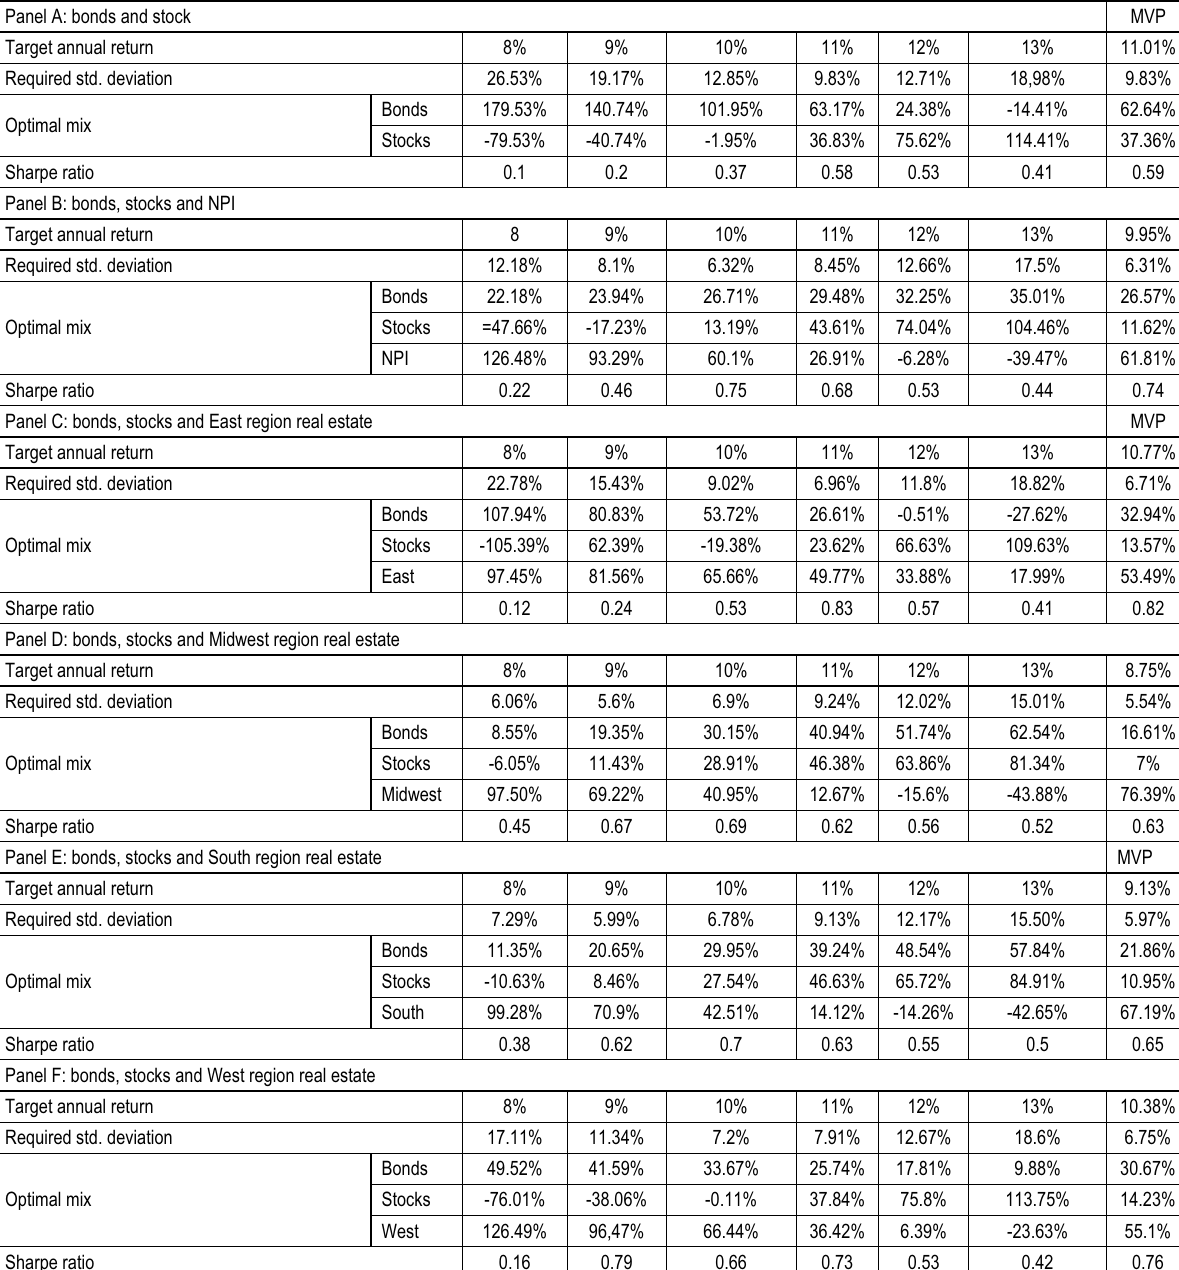
Table 3. Optimal risky portfolios at various target returns, 1978-12 (short sale allowed) This Table shows select target rates of return along with standard deviations and portfolio weights required to achieve each target rate to return. Panel A confines the portfolio to bonds and stocks only. Panel B combines bonds and stocks with real estate, as measured by NPI (national property index). Panels C-F combine real estate in each of the major regions of the country with bonds and stock. As can be seen, to achieve the desired target returns given in the Table, real estate plays a major role in the optimal portfolio. The column farthest to the right shows the weights for the minimum variance portfolio (MVP).